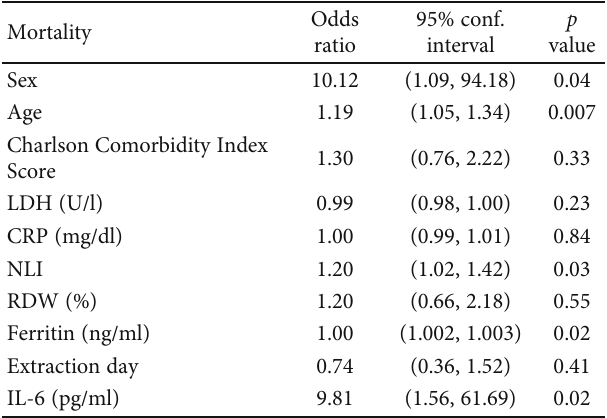
Table 5: Odds ratio (OR) for in-hospital mortality adjusted by age, sex, Charlson Comorbidity Index Score, and main analytical values in a multivariate